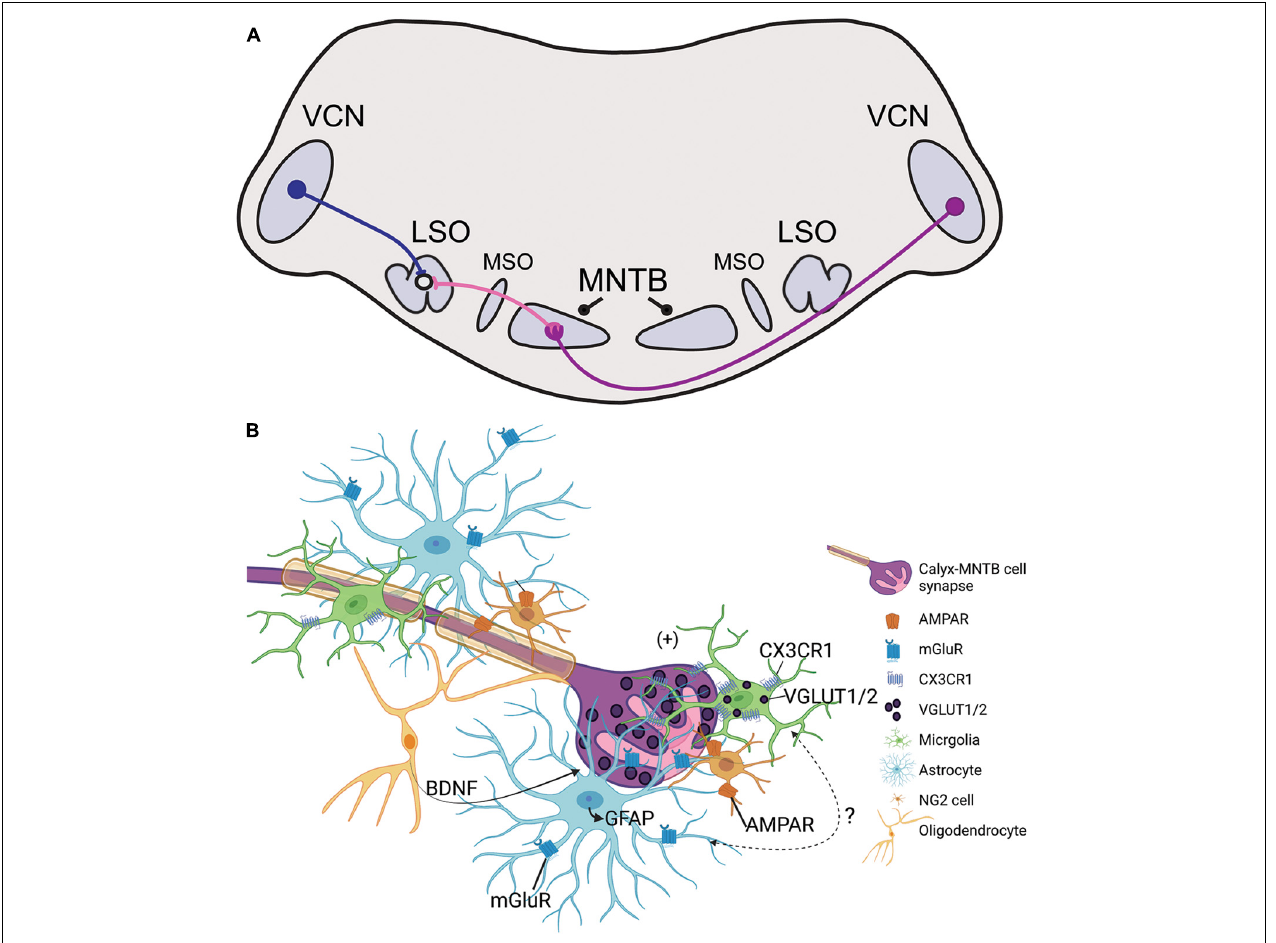
FIGURE 1 | (A) Illustration of the sound localization pathway in the auditory brainstem. Globular bushy cells (purple) cross the midline and terminate onto the contralateral medial nucleus of the trapezoid body (MNTB) through the calyx of Held. MNTB neurons provide inhibitory input to cells in the medial superior olive (MSO) and lateral superior olive (LSO; projections shown in pink). LSO neurons simultaneously receive excitatory input from the ipsilateral ventral cochlear nucleus (VCN) via spherical bushy cells (blue). The excitatory/inhibitory ratio in the LSO is used in interaural level difference computation to facilitate sound source localization. (B) Schematic representation of glial signaling at the calyx of Held during development. The GBC axon is highly myelinated and terminates in the calyx of Held (purple), which is surrounded by microglia (green), astrocytes (light blue), NG2 cells (orange), and oligodendrocytes (yellow). Glutamatergic vesicles (dark purple) are released from the calyx and dominantly modulate the MNTB neuron (pink). Synapse development and strengthening depend on oligodendrocyte secretion of BDNF, and receptors such as NG2-AMPAR and astrocyte-mGluR which respond to calyceal glutamatergic release. Microglia contain VGLUT1/2 puncta and